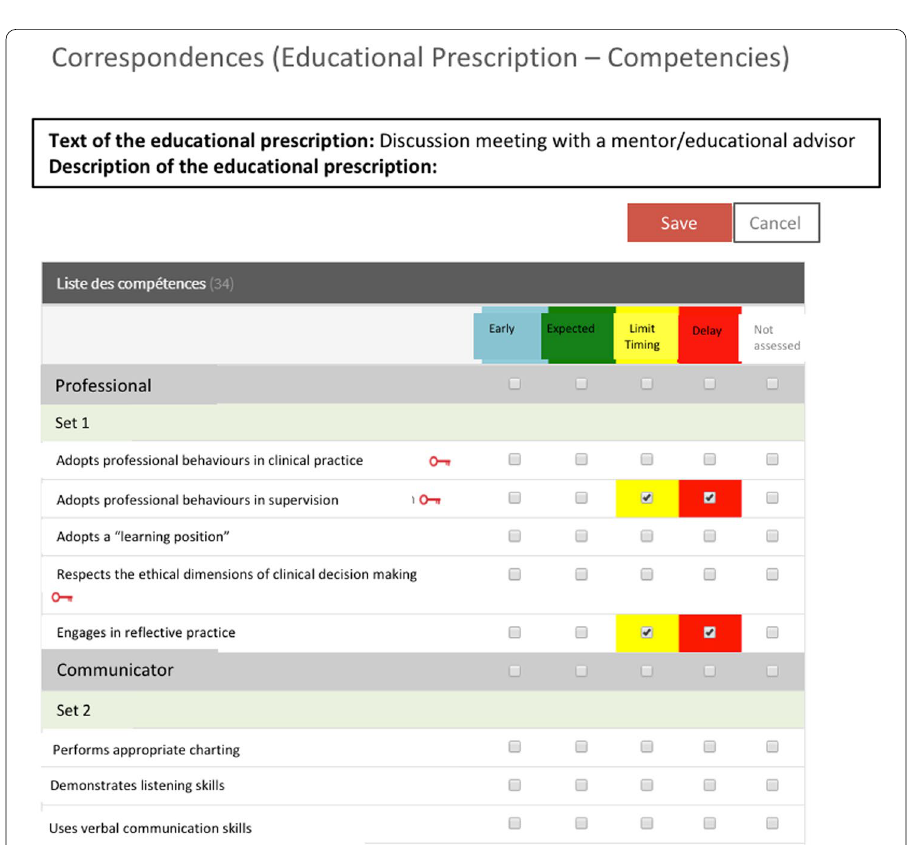
Fig. 7 Table of correspondences—educational